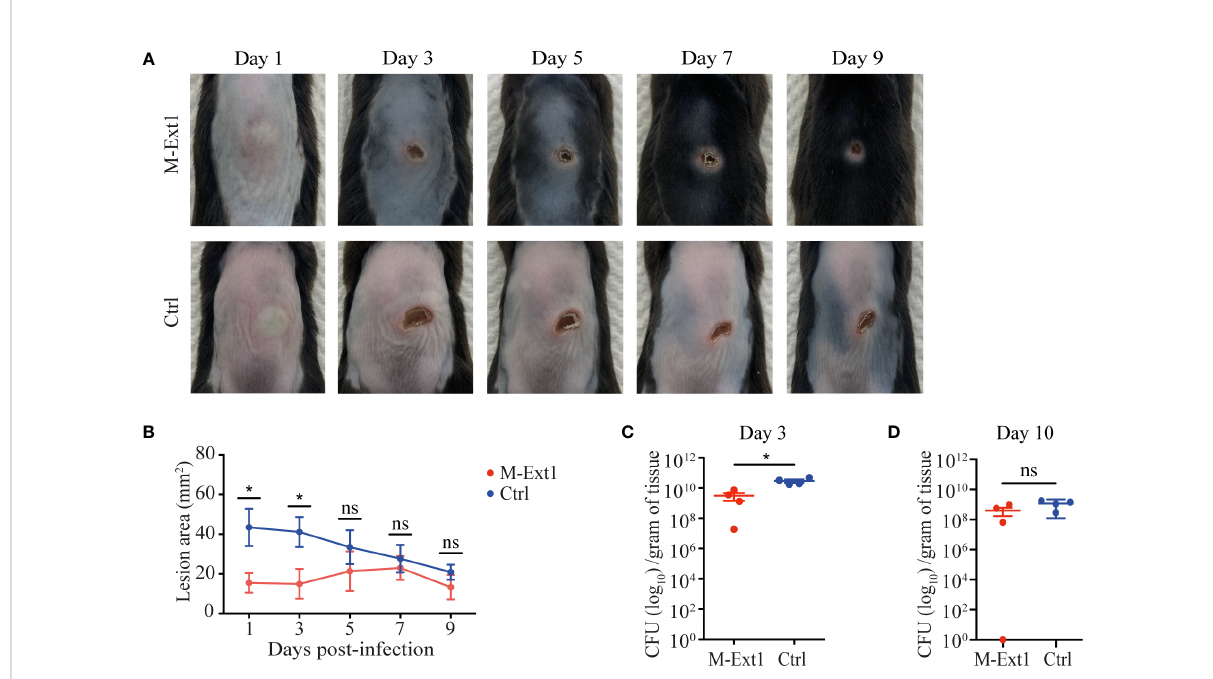
FIGURE 5 Heparin enhances the spread of skin infection. (A) Representative images of skin lesions from M-Ext1 and control mice at the indicated time points post i.d. infection with 10 7 S. aureus strain JE2. (B) Comparison of the areas of skin lesions in infected M-Ext1 and control mice at indicated times. (C) Bacterial burden in homogenized skin tissue surrounding the lesions determined at day 3 post-infection in infected M-Ext1 and control mice. (D) Bacterial burden in homogenized skin tissue surrounding the lesions at day 10 post-infection in M-Ext1 and control mice. Results are represented as mean ± SEM from 4 mice of each genotype. Each symbol in the graphs is an individual mouse. Images in (A) are representative of 4 individual mice. Statistical signi fi cance in (B) was determined by unpaired Student ’ s t-test comparing M-Ext1 to control mice at each time point. Statistical signi fi cance in (C, D) was determined by two-tailed Mann-Whitney test. Values of p<0.05 were considered statistically signi fi cant, *p < 0.05, ns, not signi fi cant.